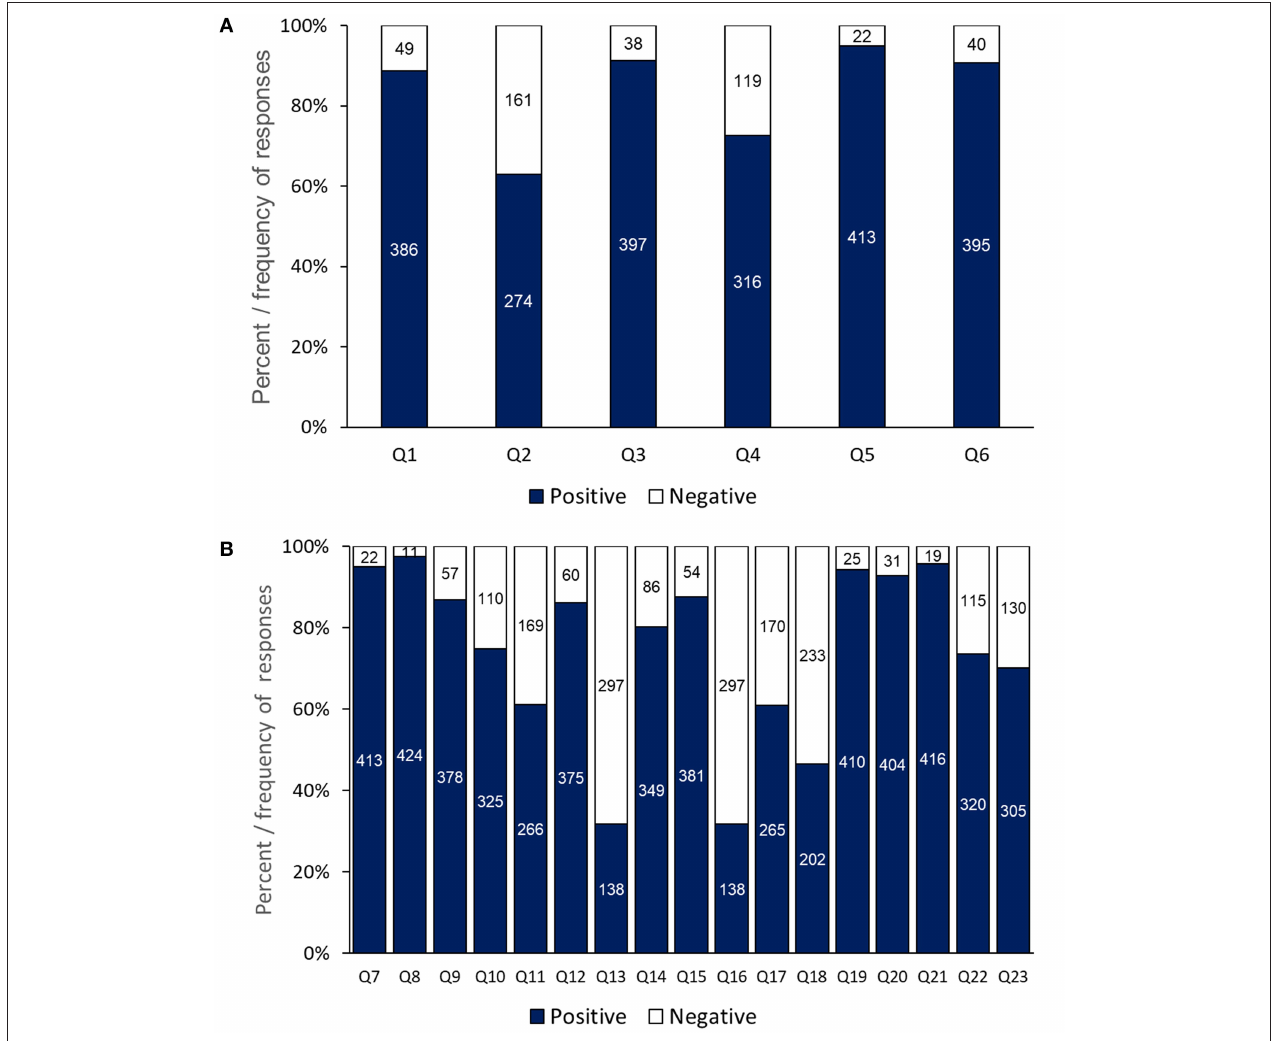
FIGURE 1 | Dentists’ responses to anxiety and awareness questions: (A) responses to individual questions on anxiety of COVID-19 and (B) awareness of precaution and infection control-measures.